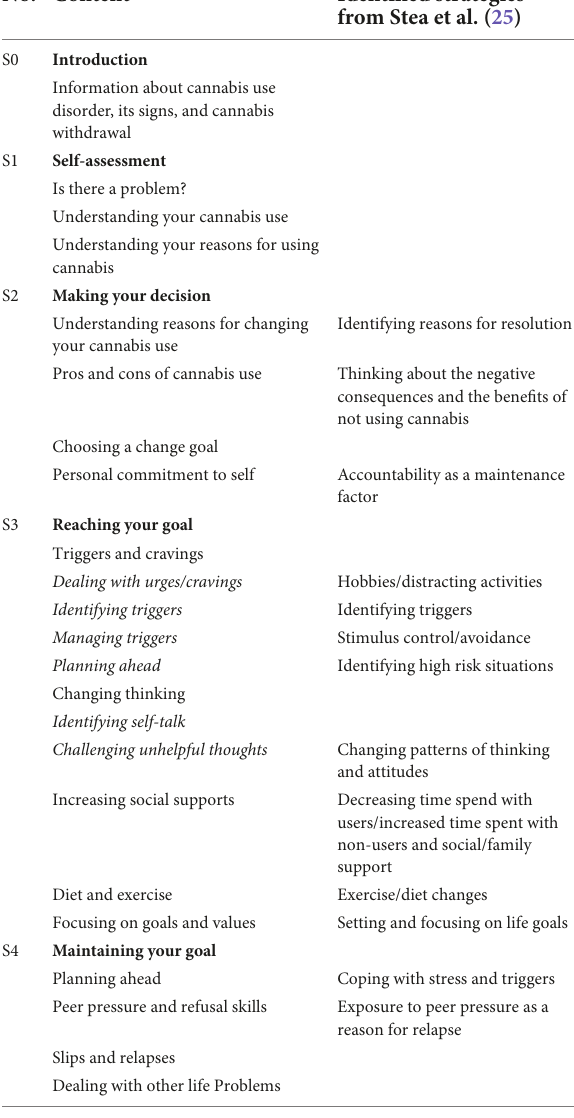
TABLE 1 Contents of the workbook and corresponding